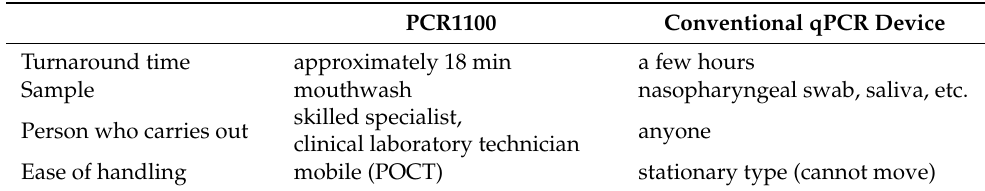
Table 9. Advantages of the PCR1100 device compared with conventional qPCR